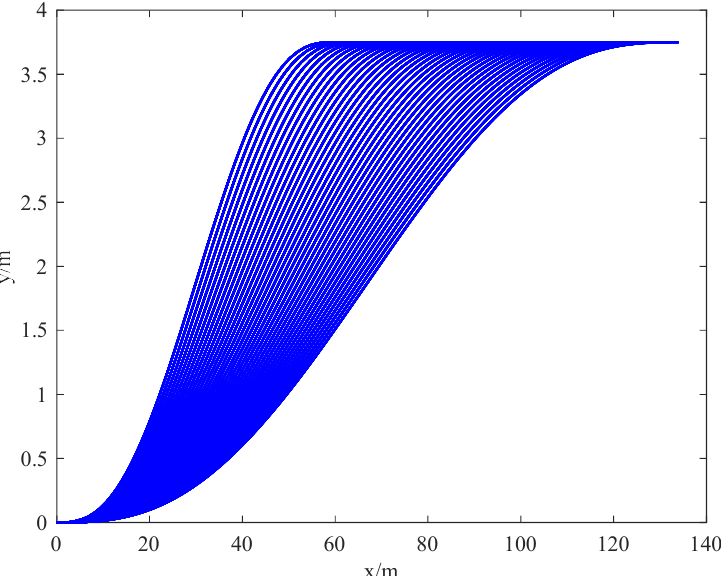
Figure 2. Unconstrained lane changing trajectory cluster.